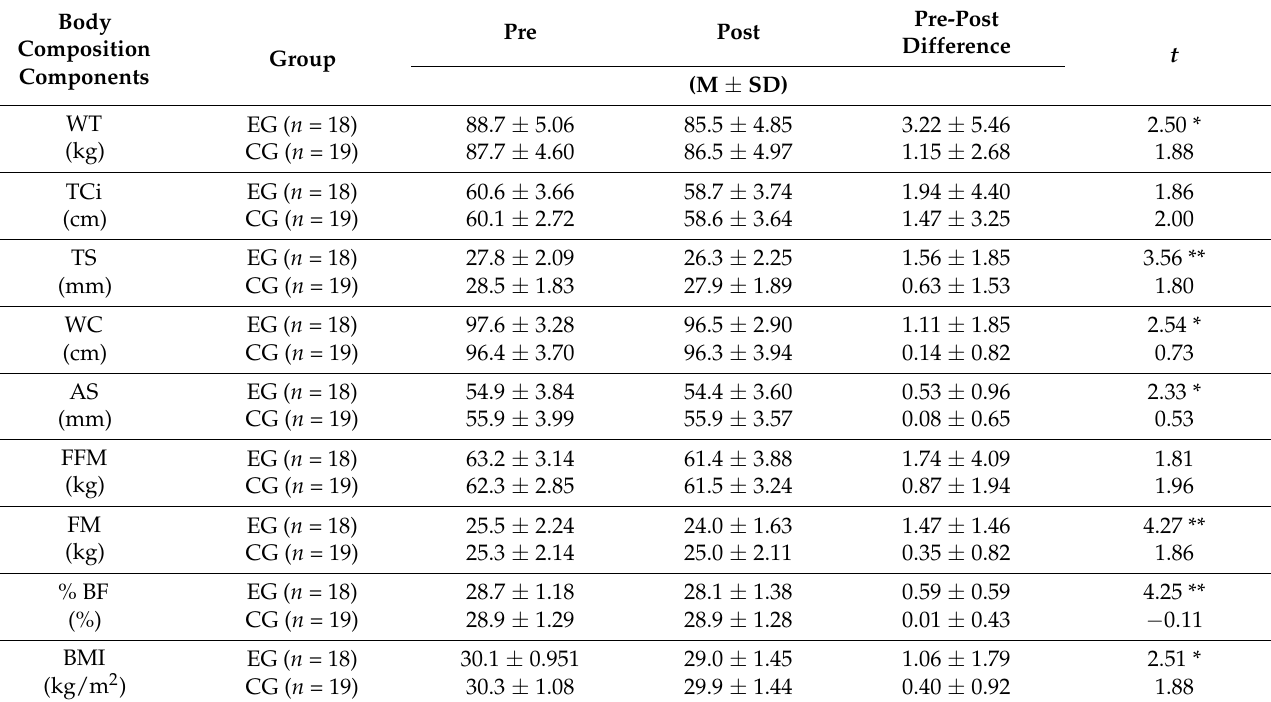
Table 3. Changes of body composition of experimental and control groups before and after 12 weeks ( t